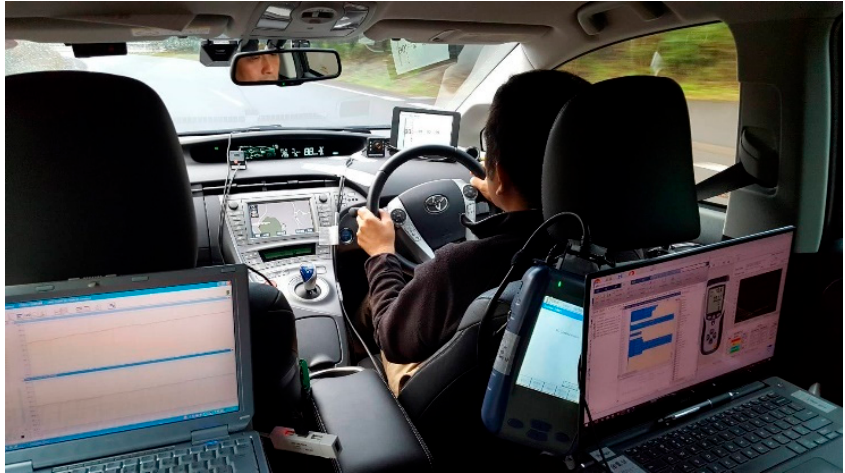
Figure 1. Analytical experimental set-up and equipment.